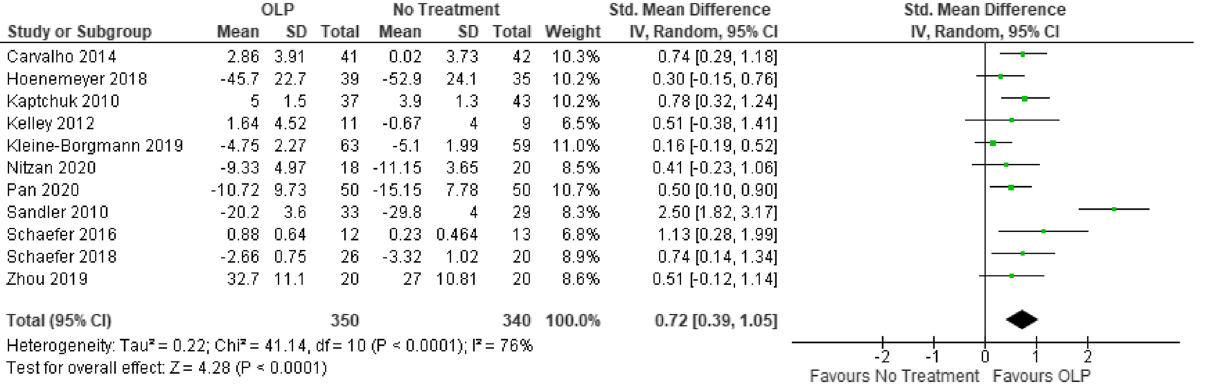
Figure 4. Forest plot for main outcome. Studies with open-label placebo (OLP) group and no treatment group were weighted using sample size (Total), means and standard deviations (SD). The means are shown by the green squares and the whiskers are representing the 95% confidence interval (CI). Overall standardized mean difference was calculated using the random effects